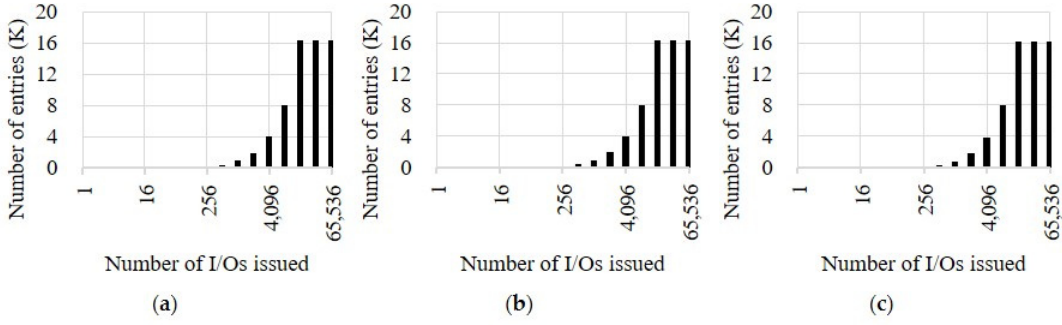
Figure 1. Number of I/O requests enqueued in the submission queue. ( a ) SSD-A; ( b ) SSD-B; ( c ) SSD-C.